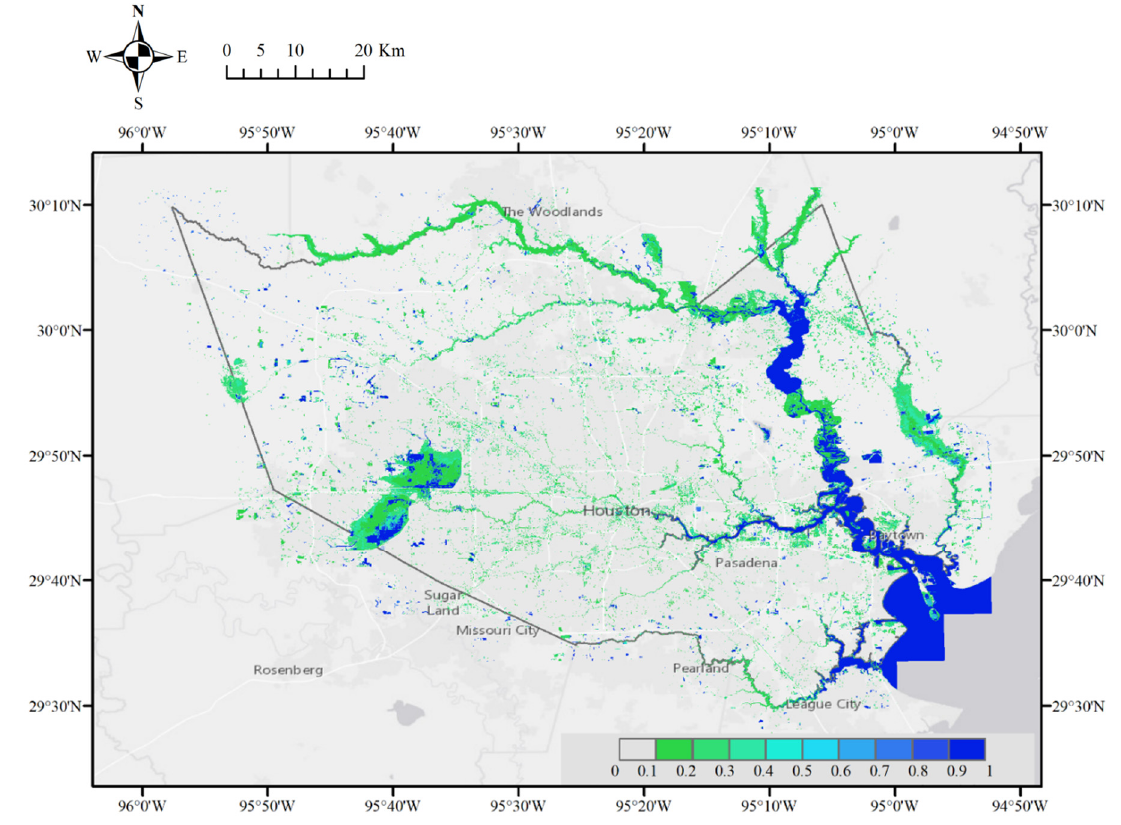
Figure 9. The posterior probability of inundation on 1 September 2017.